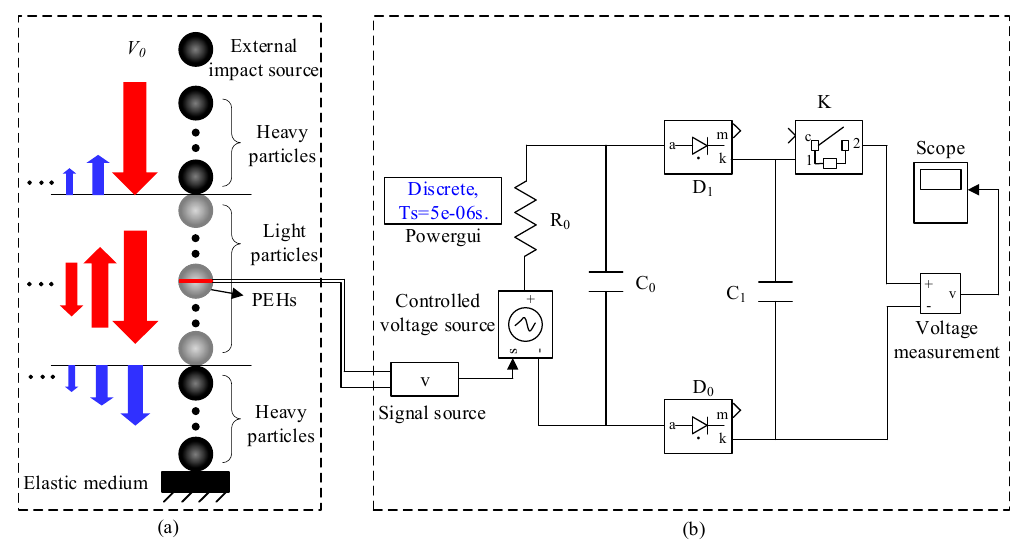
Figure 1. Simulation model of PEH : ( a ) composite particle chain and ( b ) e nergy trapping circuit based on Simulink.